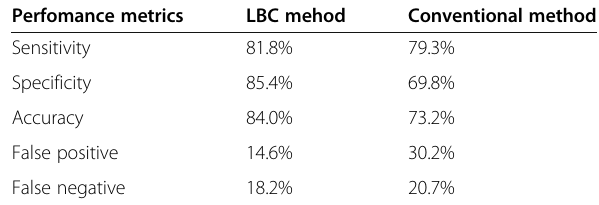
Table 4 Diagnostic performance metrics of